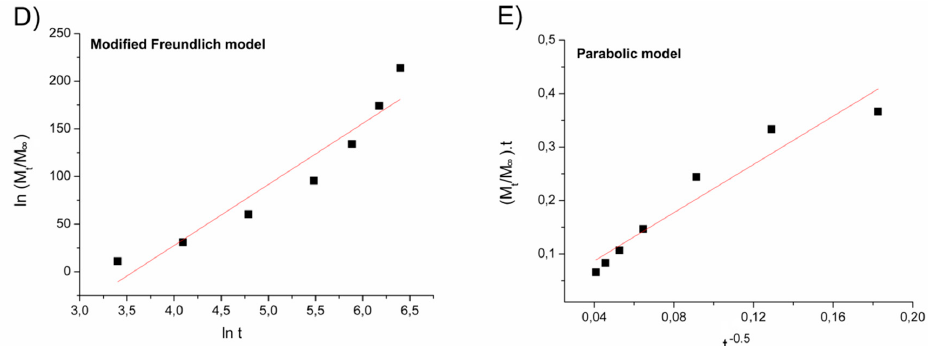
Figure 2 . Experimental in vitro release profile of ( A ) chloroquine (CQ) solution ( ● ) and chloroquine-loaded nanoparticles (CQ-NP) ( ■) from different samples and respective mathematical modeling adjustment of nanoparticles of data using: ( B ) first-order model; ( C ) Bhaskar model; ( D ) modified Freundlich model; and ( E ) Parabolic model. Notes: The data are expressed as mean ± standard deviation (SD) ( n = 2).